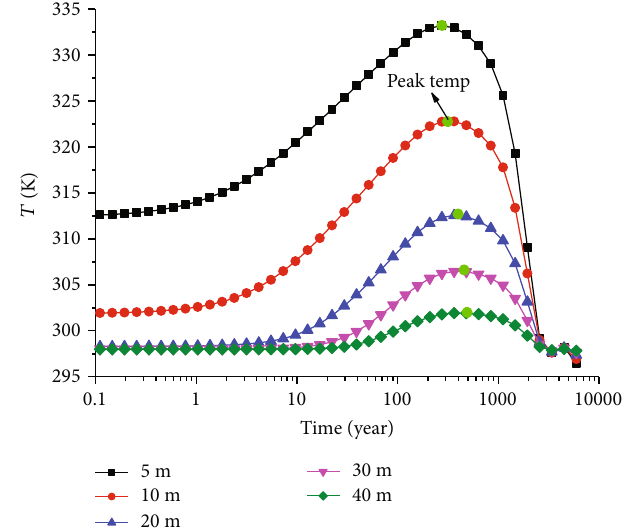
Figure 5: The evolution of reservoir temperature with time at di ff erent storage